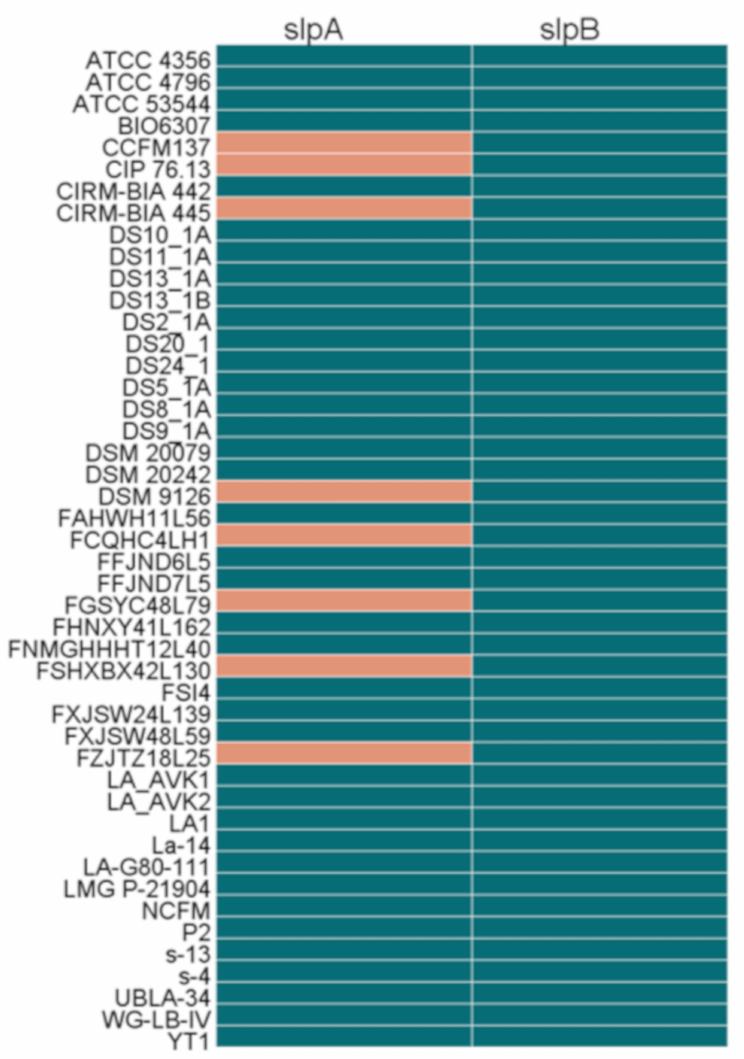
FCQHC4LH1, FGSYC48L79, FSHXBX32L130 and FZJTZ18L25 could not encode SlpA